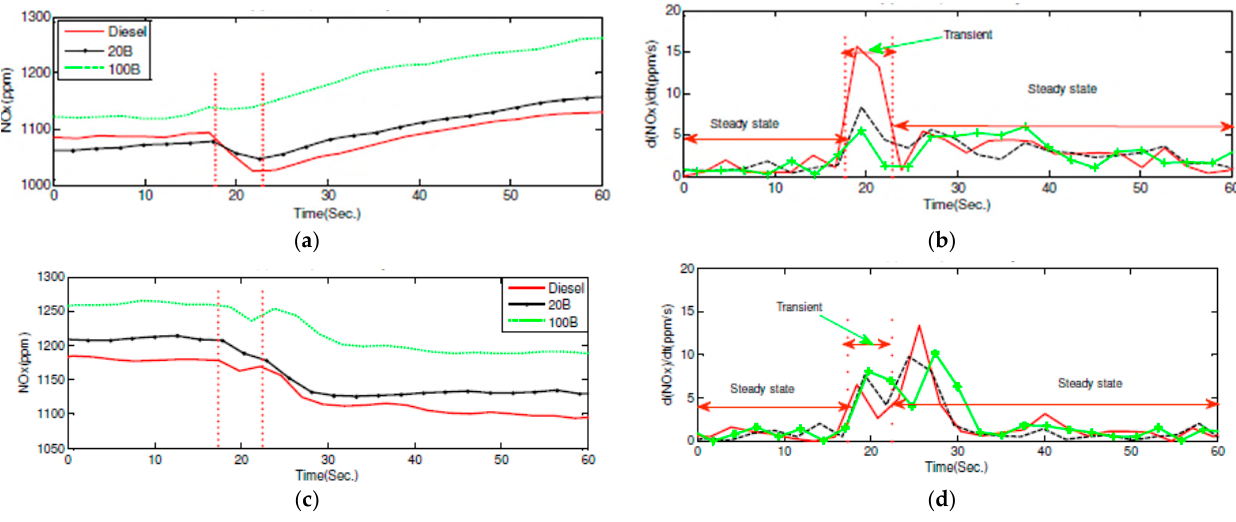
Figure 12. ( a ) NOx emission of CI engine over time running with the three fuels during positive speed transient; ( b ) equivalent rate of change of NOx emission with time. ( c ) CI engine’s NOx emission time variation running with the tested fuels during a negative speed transient; ( d ) equivalent rate of change of NOx emission during the negative speed transient.